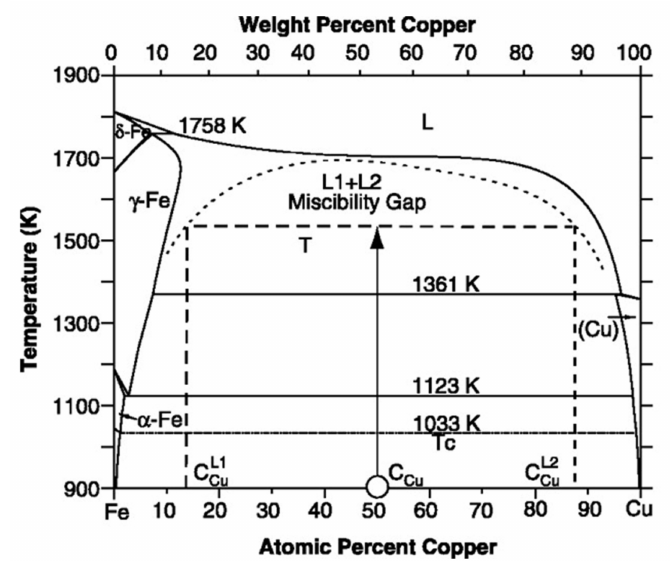
Figure 30. Fe-Cu phase diagram, showing the extended solubility of Cu in γ -Fe, and the narrow solubility limit of Cu in α -Fe, as well as the eutectoid decomposition mechanism of γ -Fe(Cu) solid solution → α -Fe + Cu. Adopted from [114], with permission from Elsevier, 2007.